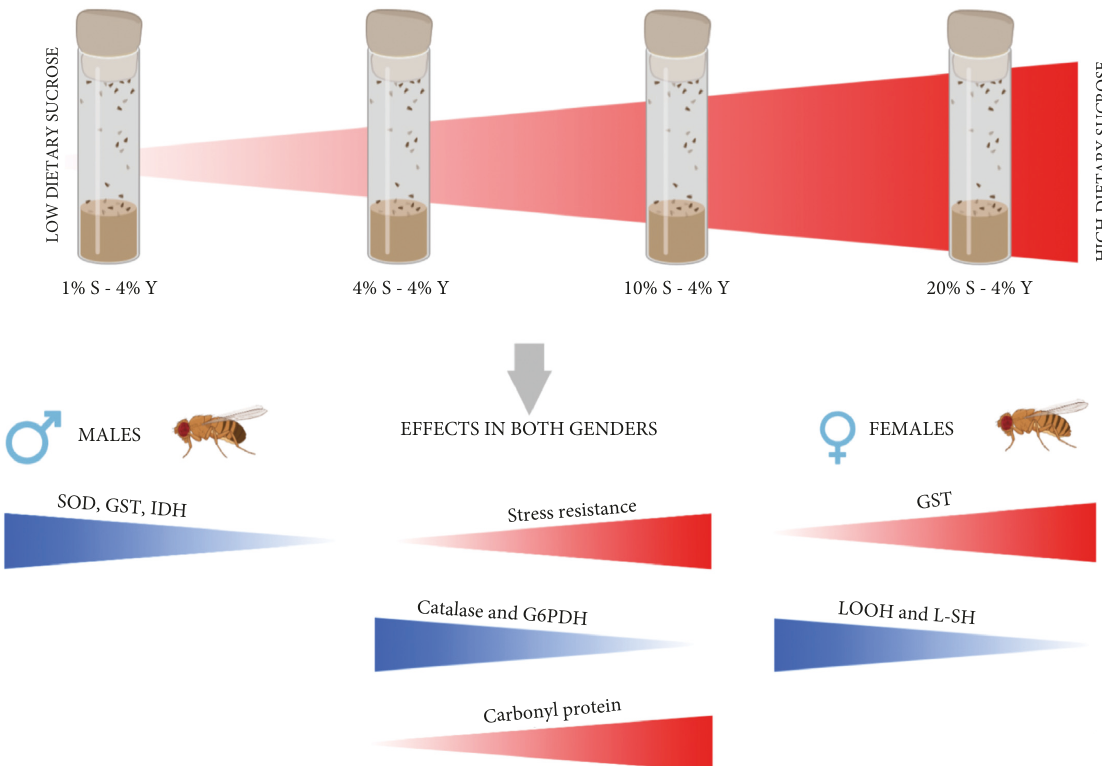
Figure 6: Effects of sucrose concentration in the diet on stress resistance, antioxidant enzymes activity, and oxidative stress markers in D.